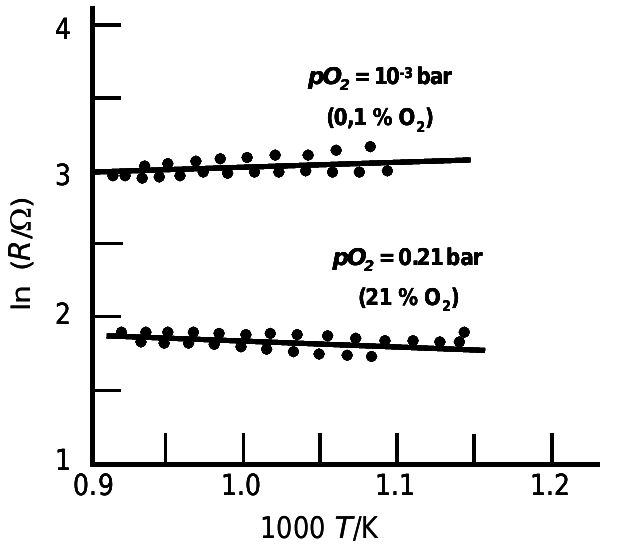
Figure 4. Resistance of a ceramic BaFe After [39], reprinted with permission from Elsevier.